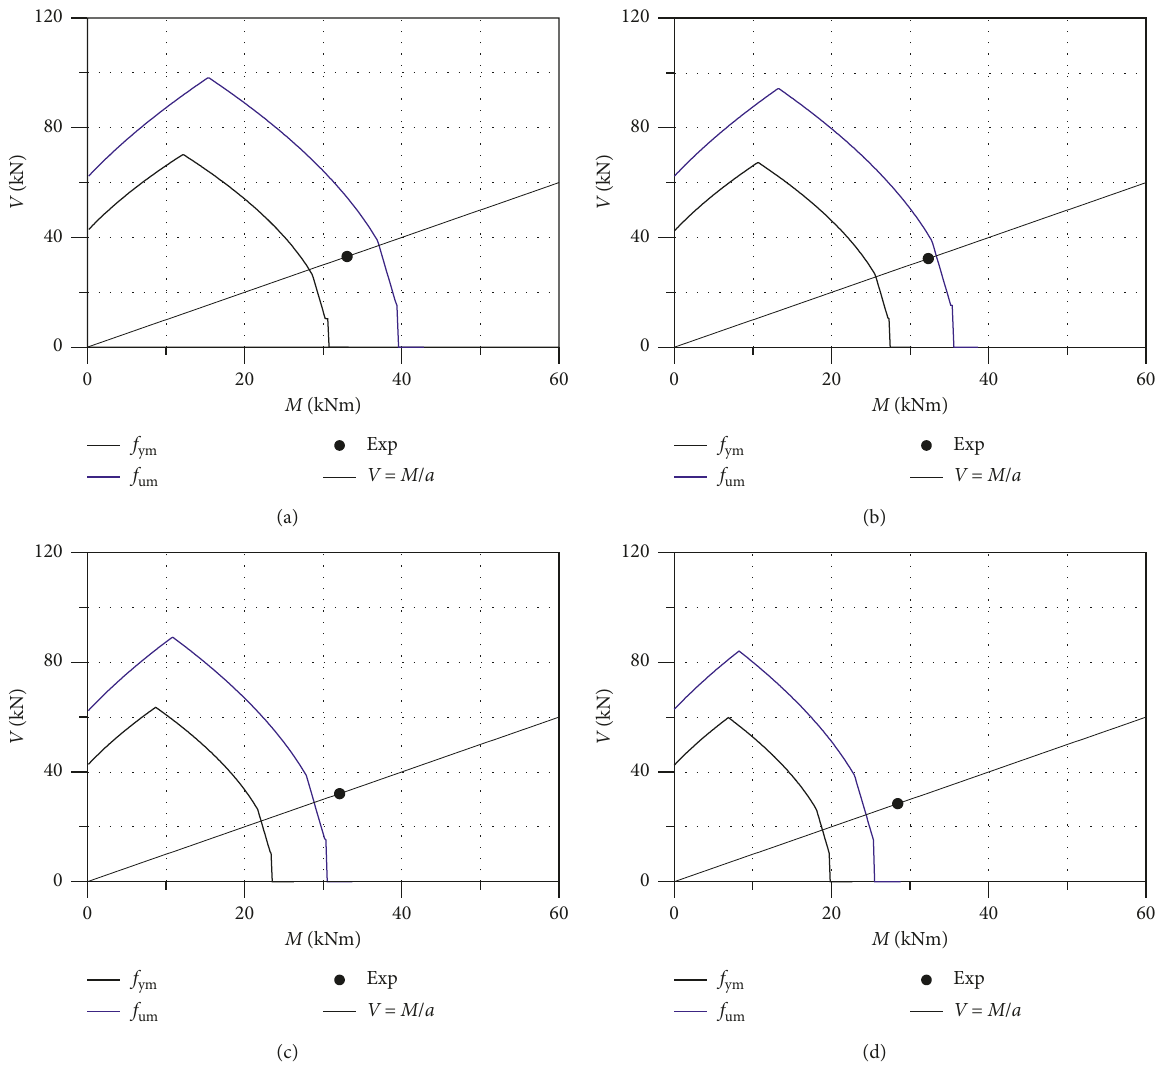
Figure 5: Interaction diagrams M - V for CS specimens tested by El Maaddawy et al. [7]. (a) CS-50, (b) CS-110, (c) CS-210, and (d)